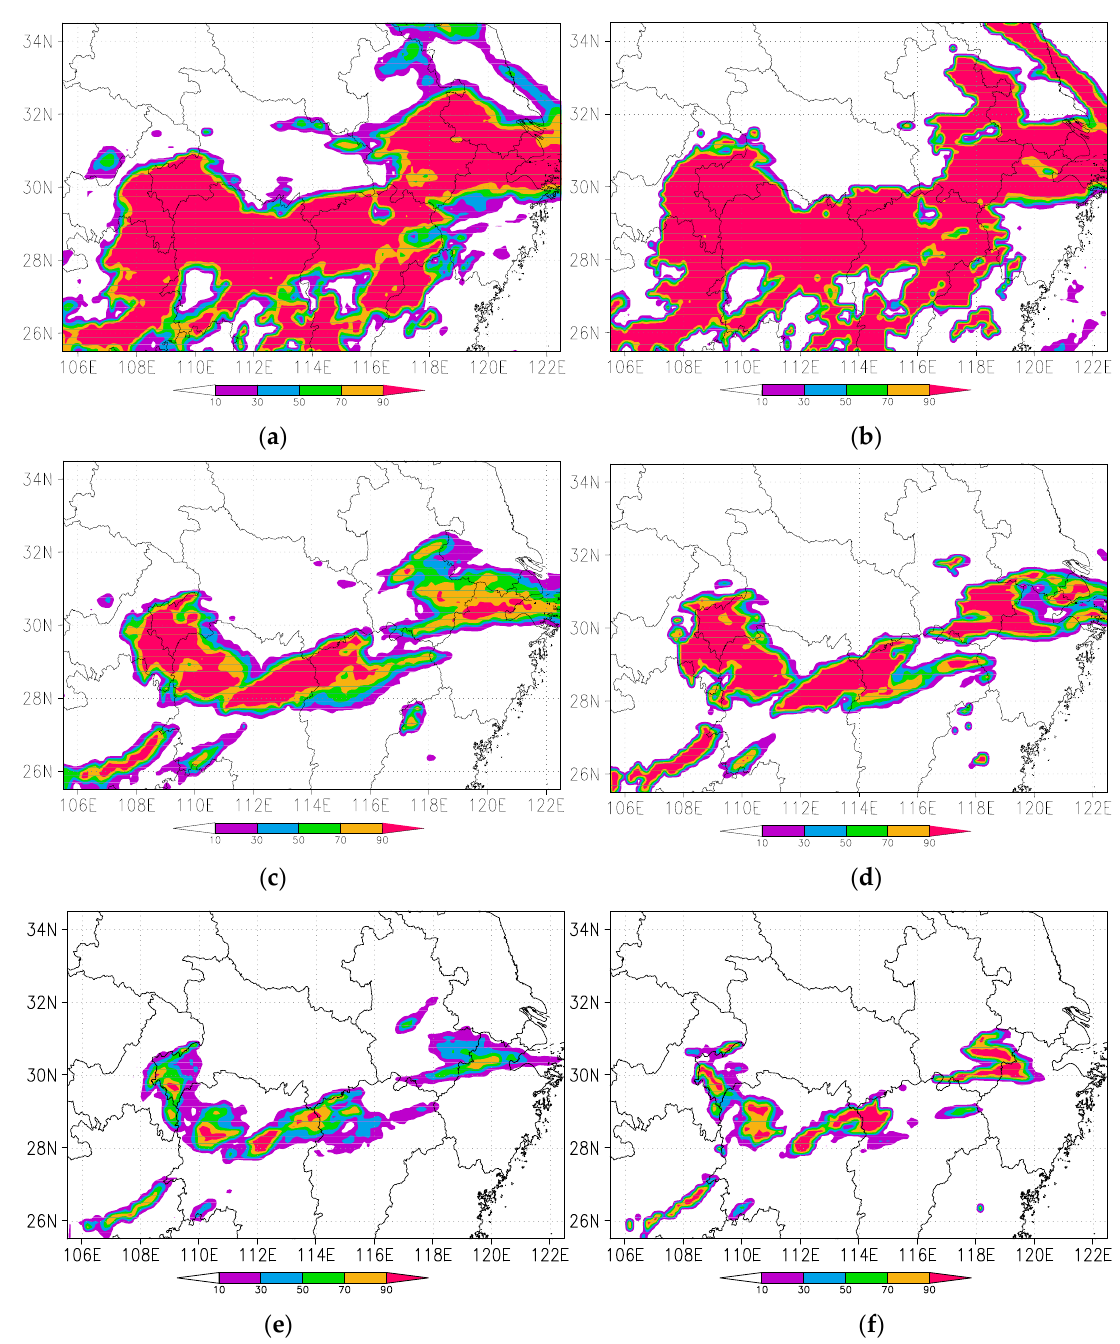
Figure 9. Forecast probability of the 24 h cumulative precipitation at different intensity levels (%). ( a ) ATM subset > 10 mm precipitation, ( b ) LSM subset > 10 mm precipitation, ( c ) ATM subset > 25 mm precipitation, ( d ) LSM subset > 25 mm precipitation, ( e ) ATM subset > 50 mm precipitation, ( f ) LSM subset > 50 mm precipitation.